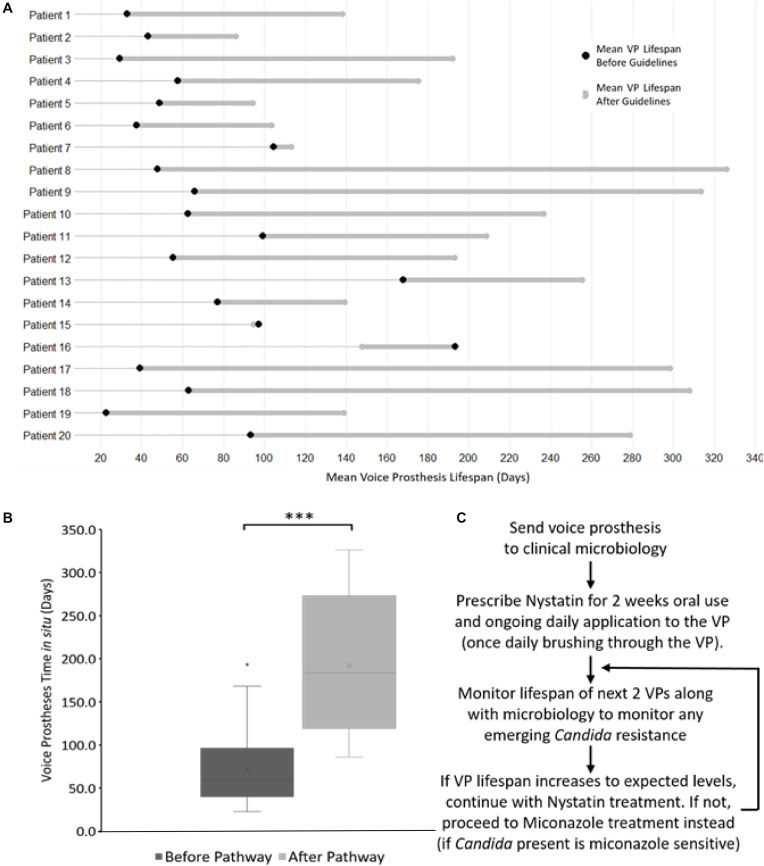
The antifungal treatment guidelines along with its effects on voice prosthesis lifespan within each patient. (A) Dumbbell chart representation of the mean VP lifespan difference after guideline implementation for each of the 20 patients. (B) Box plot representation of VP in situ lifespans before and after guideline implementation, Wilcoxon Signed-Rank test: ***p < 0.001. (C) Summary of the treatment pathway. As of January 2019, this management pathway has been distributed to 34 different speech and language therapy centers (32 in the United Kingdom, 2 internationally) upon request.